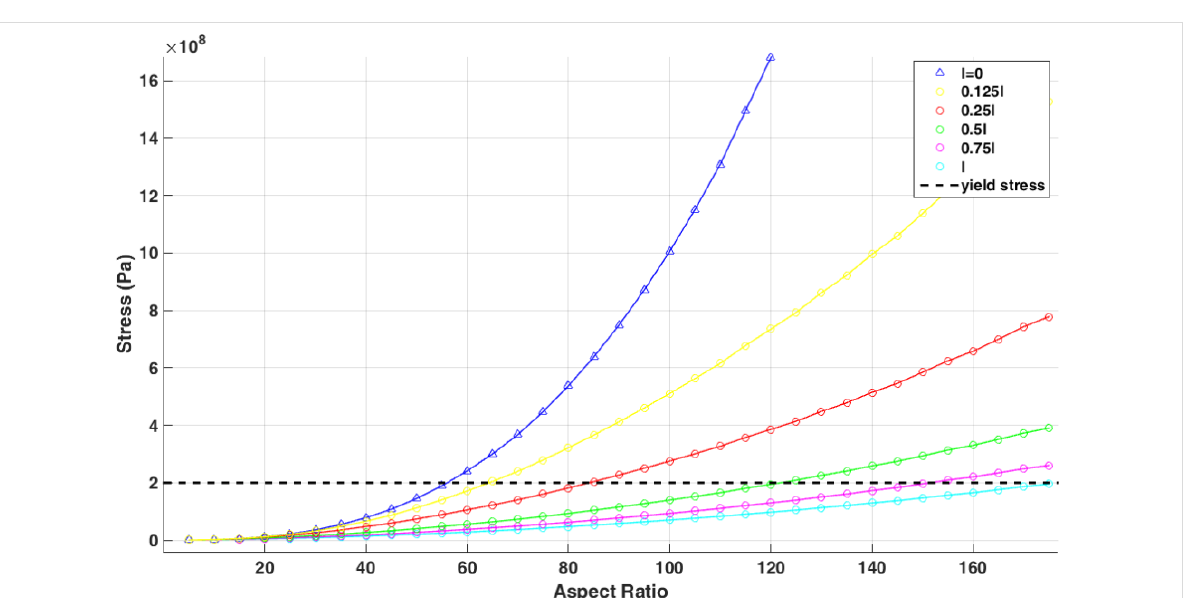
Figure 17: Variation of nonclassical equivalent stresses with material length scale parameter and change in aspect